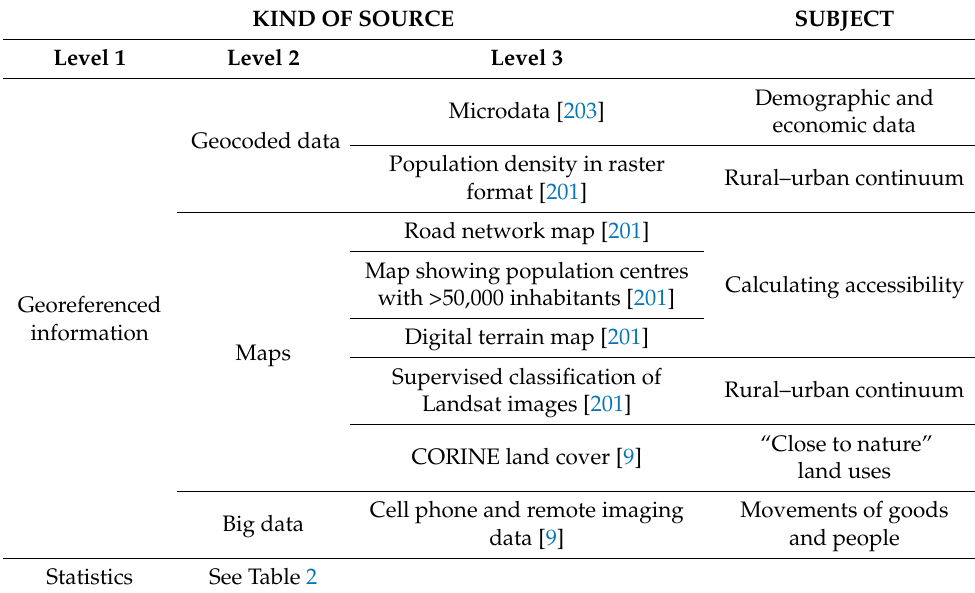
Table 1. Index of the sources used, based on the literature consulted.